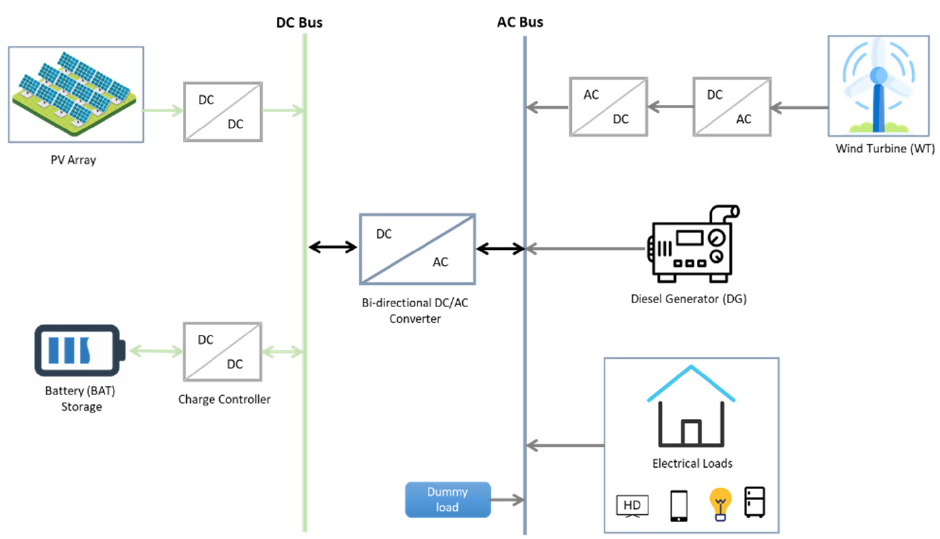
Figure 1. An example of an off-grid hybrid renewable energy system (HRES).